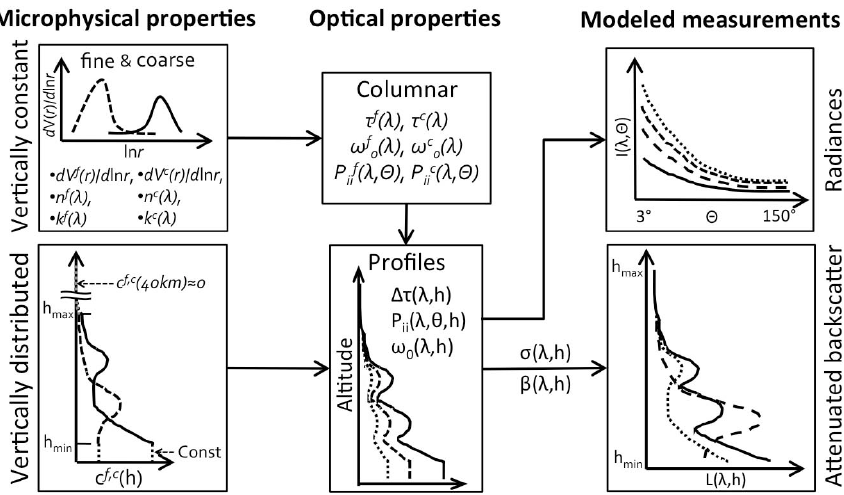
Fig. 3. General scheme of the measurements modelling using a two-component vertically distributed aerosol